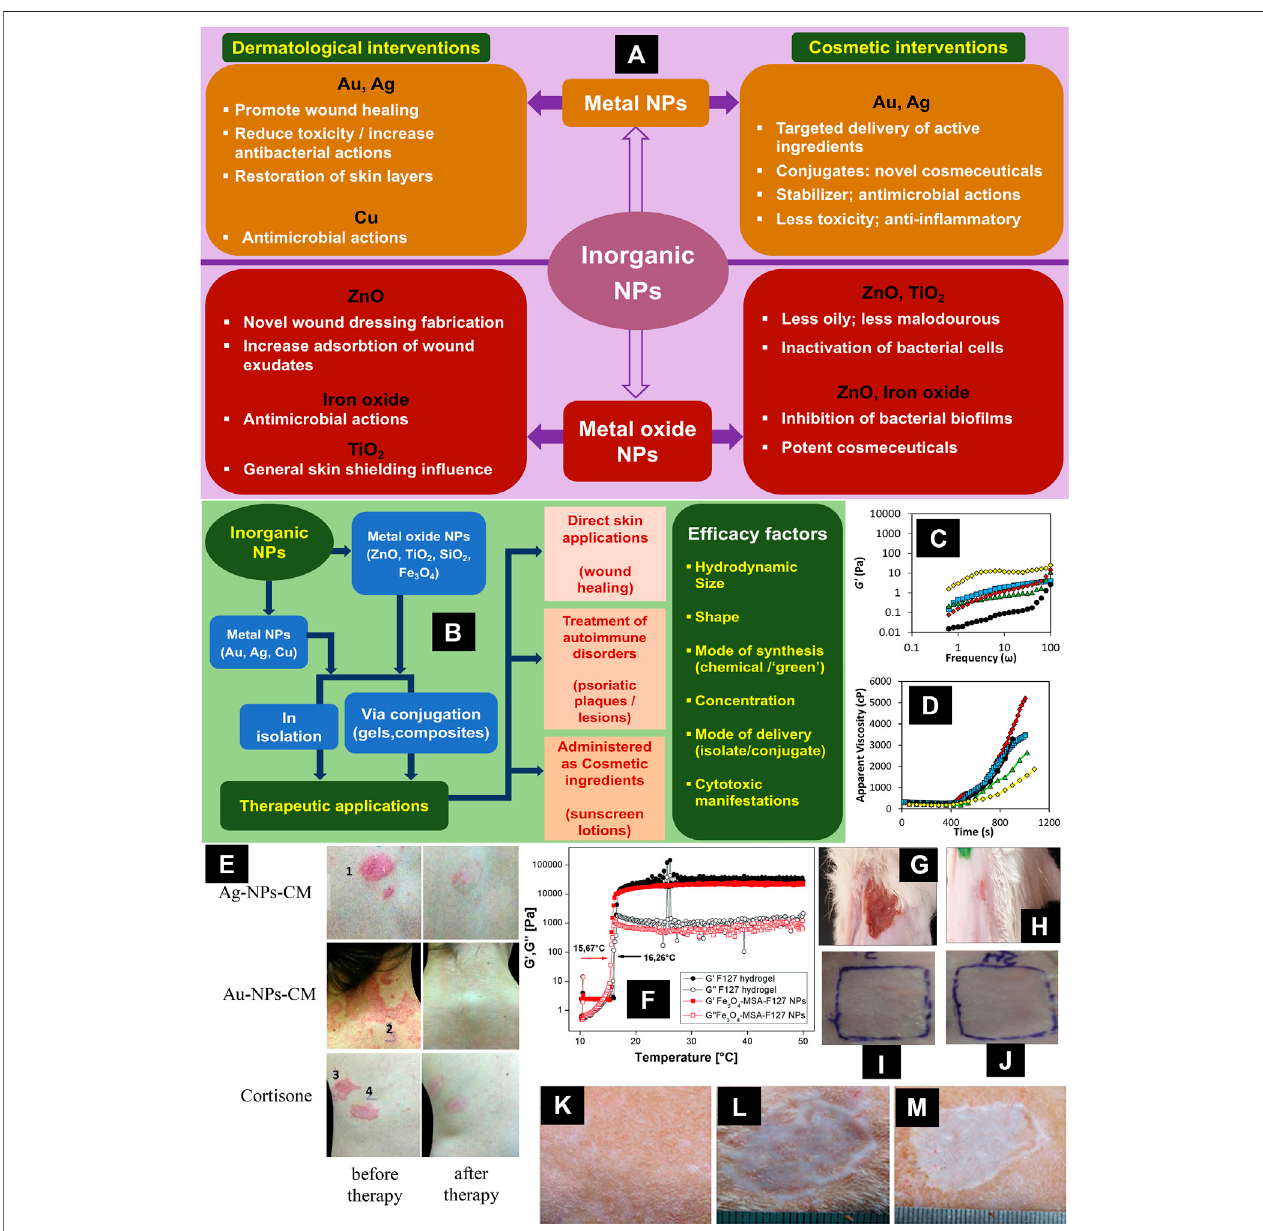
FIGURE 1 | (A) : Representative schematic of various dermatological and cosmetic interventions of the metal and metal oxide NPs considered in the current minireview. (B) : Representative schematic illustrating an all-inclusive premise of the current minireview. (C,D) : Ef fi cacy of rheological characterizations in assessing mechanical and gelation properties of polymer gels incorporated with different metal oxide Nps. Linear elastic modulus (G ′ ) as a function of imposed angular oscillation frequency at different NP concentrations (C) . Temporal evolution ofthe apparent viscosity during gelation in the presence and absence of different NPs at different polymer concentrations (D) . Legend: Open diamond — Chromium (III) oxide; closed diamond — Aluminium oxide; closed triangle — Silicon dioxide; closed square — Magnesium oxide; closed circle — gel without NPs. Reproduced and adapted from Pérez-Robles et al. (2020). Open Access. © 2019 Pérez-Robles et al. (E) : Noteworthy reduction in psoriasis plaques, scaling and erythema in human volunteers, after 6 weeks of administration of gold and silver NPs, via the Cornus mas conjugates.ReproducedwithpermissionfromCrisanetal.(2018).©2018JohnWileyandSonsA/S. (F) :Ef fi cacyofrheologyinassessingthetemperaturedependence of the mechanical properties (linear viscoelastic moduli: G ′ and G ″ ) of superparamagnetic iron oxide NPs dispersed in Pluronic F127 hydrogel. Reproduced from Gonçalvesetal.(2017).OpenAccess.©TheRoyalSocietyofChemistry2017. (G,H) :Ef fi cacyofgoldNPsinwoundhealing.Burnwoundpositiononmousedorsalskin treated with F1 formula (AuNPs-PF127), mouse before application; day 1 (G) , mouse after end of treatment; day 9 (H) . Reproduced from Arafa et al. (2018). Open Access. © Arafa et al. (2018). (I,J) : Ef fi cacy of metal oxide NPs in a dermato-cosmetic application. Response for conventional titanium dioxide cream after 48 h (I) . Response for titanium dioxide NPs cream after 48 h ( J ). Reproduced with permission from Singh and Nanda (2014). © 2014 Society of Cosmetic Scientists and the Société Française de Cosmétologie. (K – M) : Ef fi cacy of silver NP loaded collagen/chitosan scaffolds (NAg-CCS) in wound healing. Gross views of normal skin (K) and woundstreatedbyNAg-CCS (L) andCCS (M) atday60posttransplantation,respectively.Ultra-thinautograftsweretransplantedatday10.ReproducedfromYouetal. (2017). Open Access. © You et al., 2017. Abbreviation: NP — nanoparticle, NPs — nanoparticles.